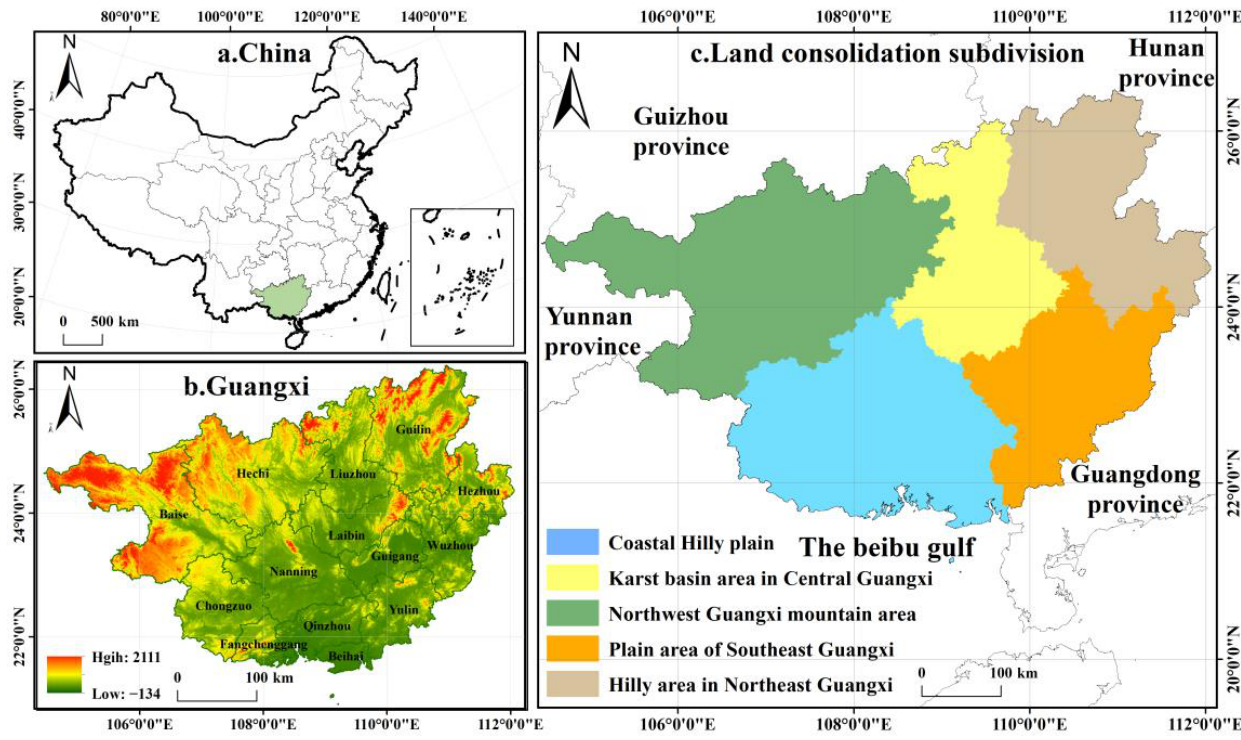
Figure 1. Guangxi land consolidation zoning map.